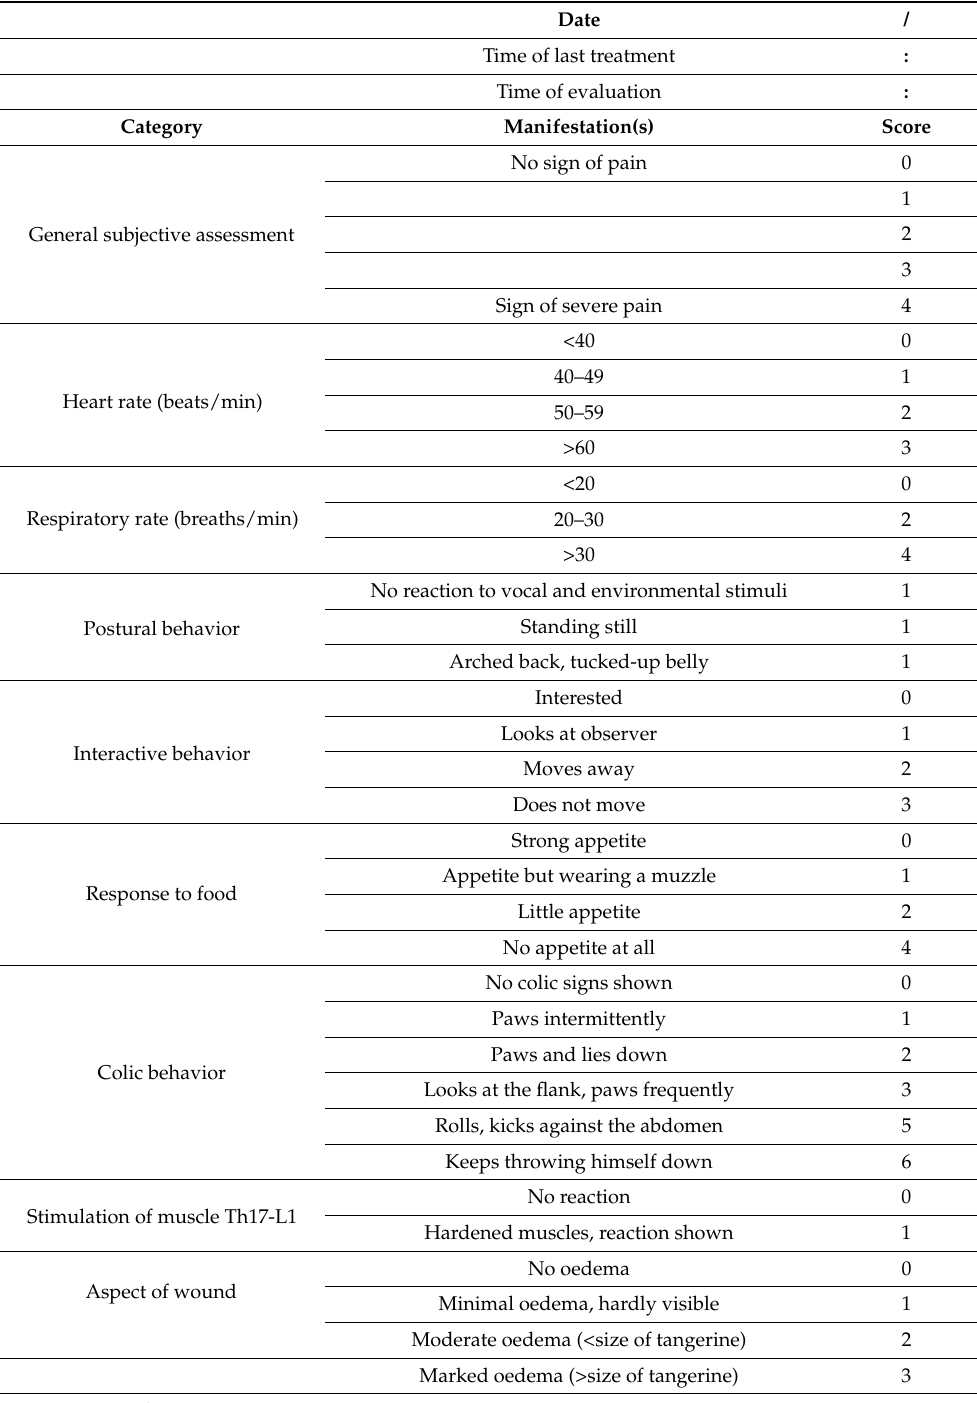
Table 1. Composite pain score adapted from Graubner et al. [4]. Total score (out of 31): score ≤ 7: mid pain; score = 8–14: moderate pain; score > 14: severe